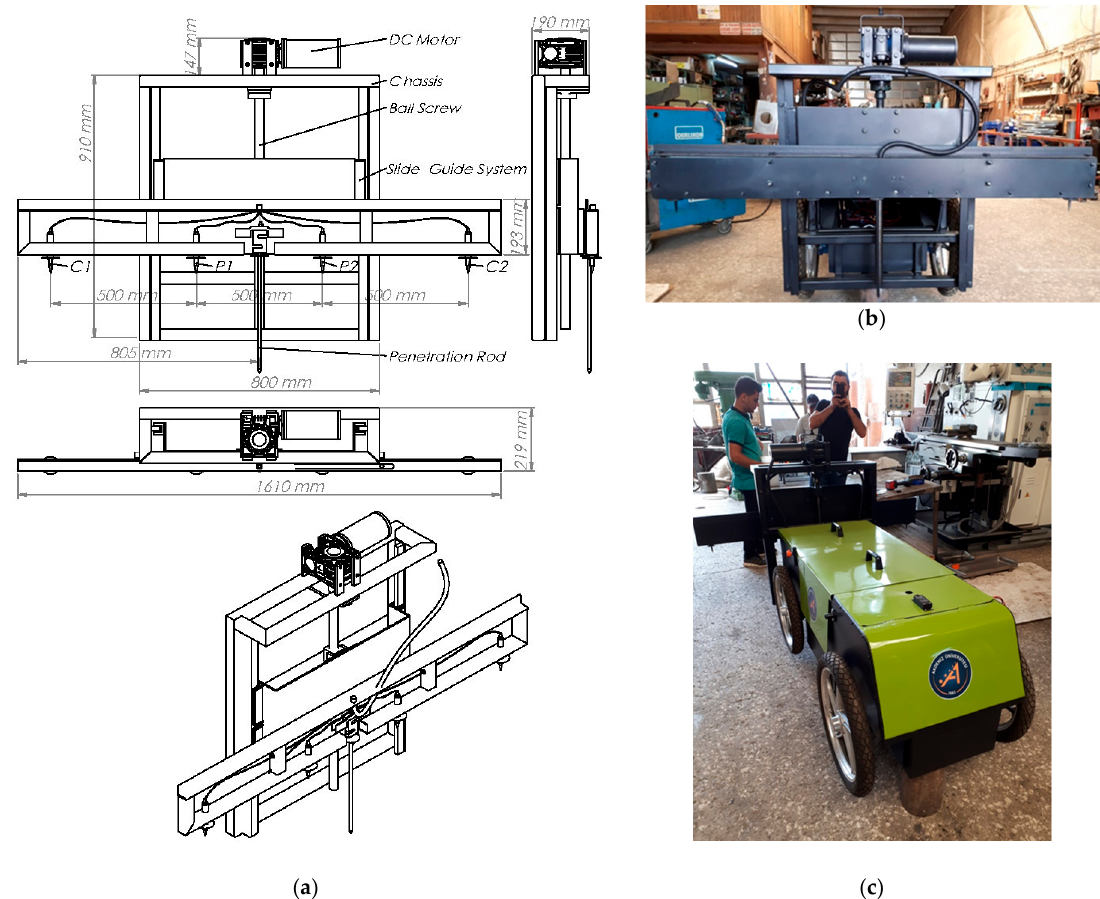
Figure 2. The developed measurement system. ( a ) Full scale technical drawing of the measurement platform; ( b ) full developed measurement platform; ( c ) four-wheel drive agricultural robot, which has the Wenner measurement system.